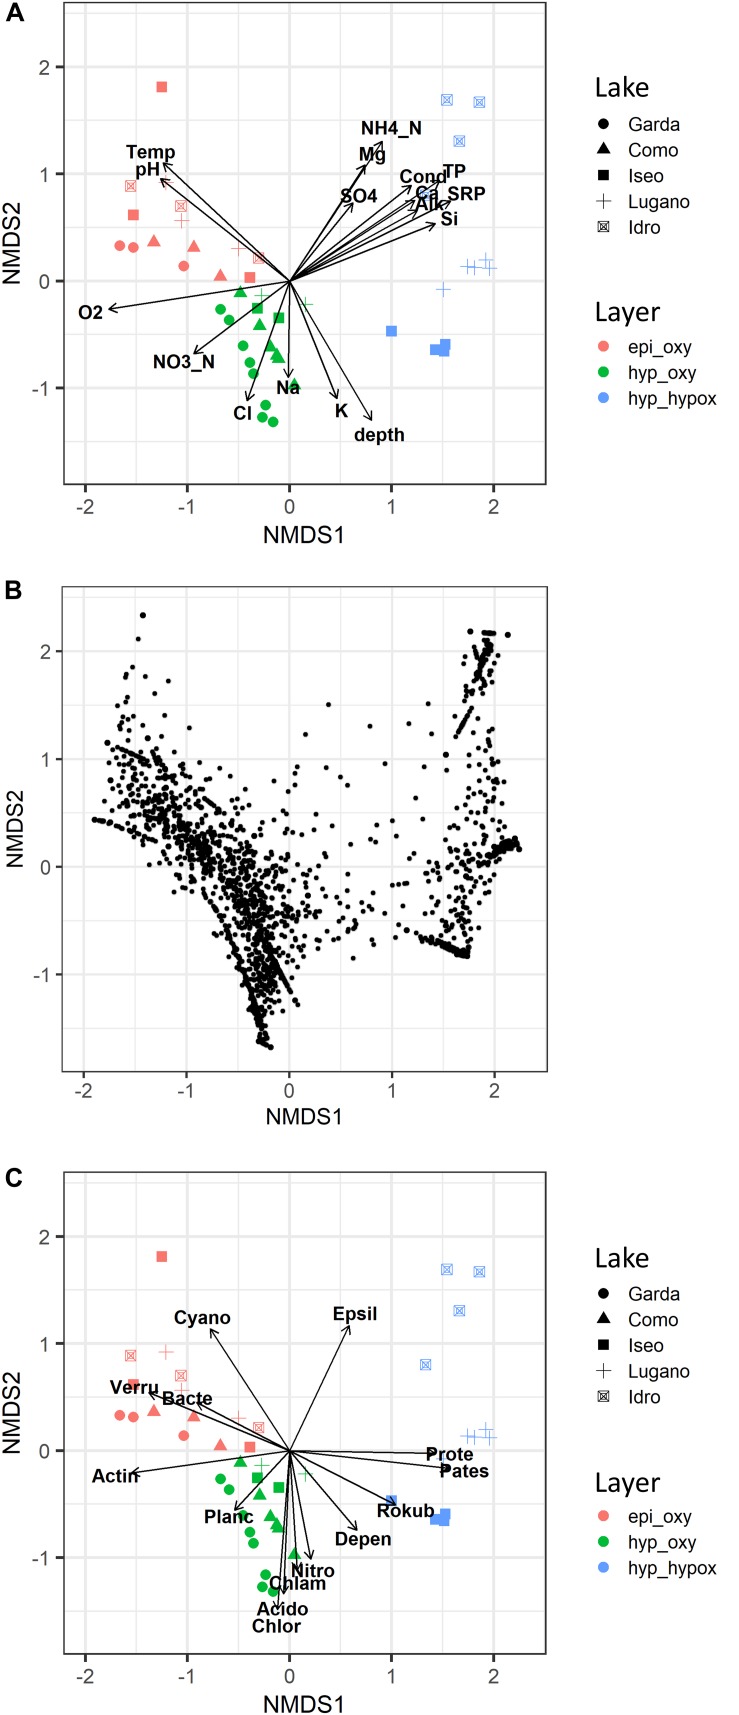
Non-metric multidimensional scaling (NMDS) ordination (stress = 0.09) of samples based on the bacterioplankton composition; samples are coded by lake name (symbols) and layer (colors). (A) Vector fitting of significant (P < 0.01) environmental variables: Temp, water temperature; Cond, water conductivity; O2, dissolved oxygen; SRP, soluble reactive phosphorus; TP, total phosphorus; NO3_N, nitrate nitrogen; NH4_N, ammoniacal nitrogen; Si, reactive silica; Alk, alkalinity; SO4, sulfate; depth, sampling depth; other major ions are indicated by the element name. (B) Ordination of ASVs. (C) Vector fitting of significant (P < 0.01) dominant phyla: Acido, Acidobacteria; Actin, Actinobacteria; Bacte, Bacteroidetes; Chlam, Chlamydiae; Chlor, Chloroflexi; Cyano, Cyanobacteria; Depen, Dependentiae; Epsil, Epsilonbacteraeota; Nitro, Nitrospirae; Pates, Patescibacteria; Planc, Planctomycetes; Prote, Proteobacteria; Rokub, Rokubacteria; Verru, Verrucomicrobia. epi_oxy, 0–20 m layer; hyp_oxy, oxygenated hypolimnion; hyp_hypox, hypoxic/anoxic hypolimnion.